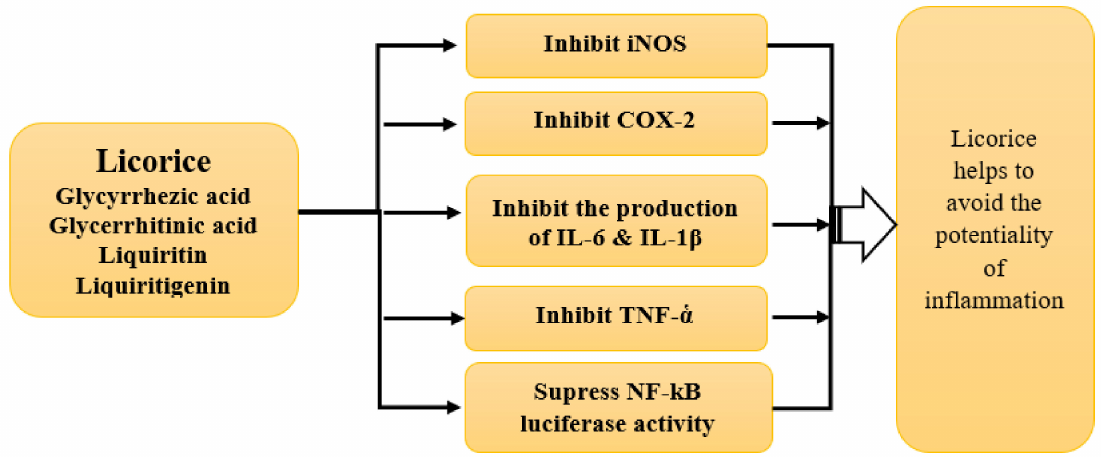
Table 1. A list of major bioactive compounds identified in licorice together with their therapeutical properties. Bioactive Compounds